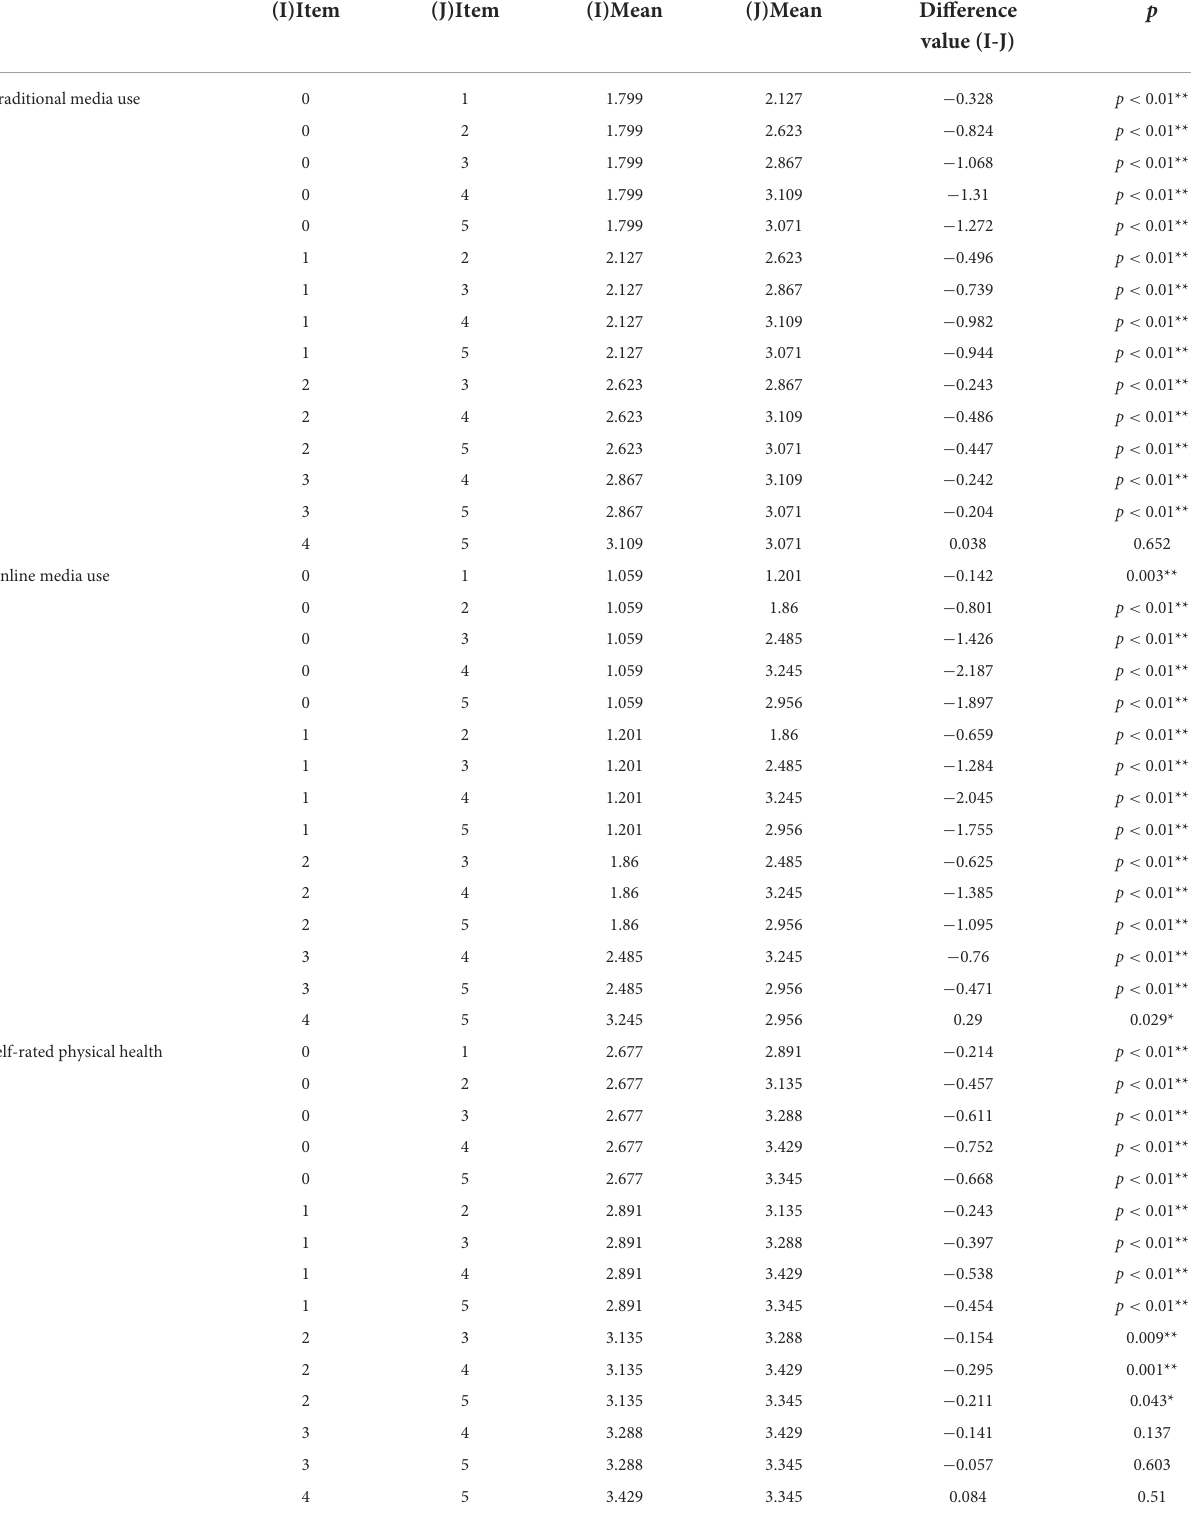
TABLE 4 Results of post hoc